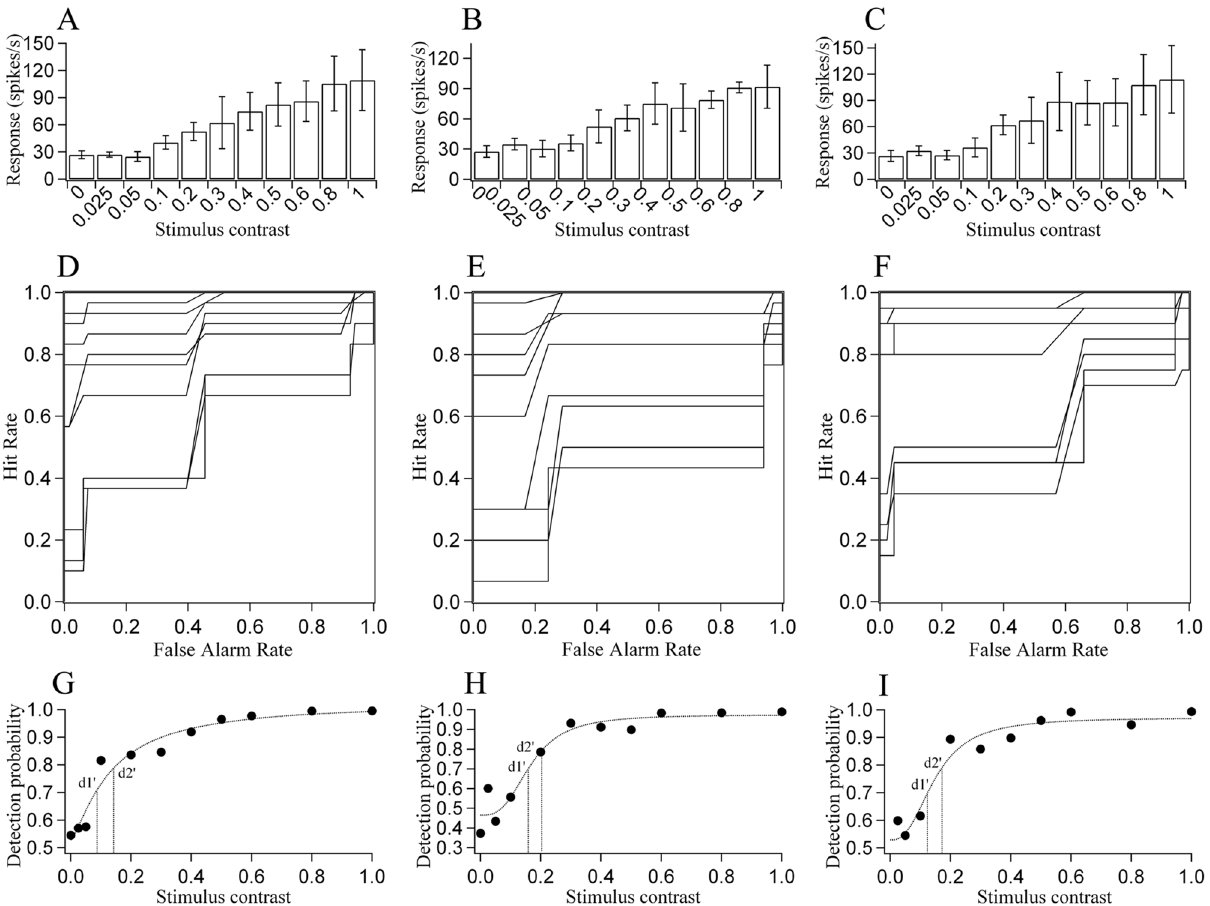
Figure 7. A sample cell showing the ROC analysis for measurement of the threshold contrast that the V1 neuron can respond to the visual stimuli at two performance criteria (d1 ′ = 70.7%, and d2 ′ = 79.3%) before and after c-tDCS in the area 7 (A7) of visual cortex. ( A – C ) Contrast response functions showing the mean neuronal response to repeated presentation (6 × 5 trials) of visual stimuli with different luminance contrast (0, 0.025, 0.05, 0.1, 0.2, 0.3, 0.4, 0.5, 0.6, 0.8 and 1.0) before ( A ) and immediately after ( B ) c-tDCS as well as after recovery from c-tDCS effect ( C ). ( D – F ) ROC showing the hit rate versus false alarm rate for neuronal response value distribution at different stimulus contrasts compared with that at contrast 0 before ( D ) and immediately after ( E ) c-tDCS as well as after recovery from c-tDCS effect ( F ). ( G – I ) showing the probability (solid circles) of the neuron in detection visual stimuli with different contrasts before ( G ) and immediately after ( H ) c-tDCS as well as after recovery from c-tDCS effect ( I ). The solid curves represent the best-fitting of detection probability versus stimulus contrast functions with Weibull equation. The dashed lines indicate the contrast threshold (TC) at two performance criterion of d1 ′ and d2 ′ , respectively. Image created using Igor (version 6.3.1.2, www. wavem etrics.